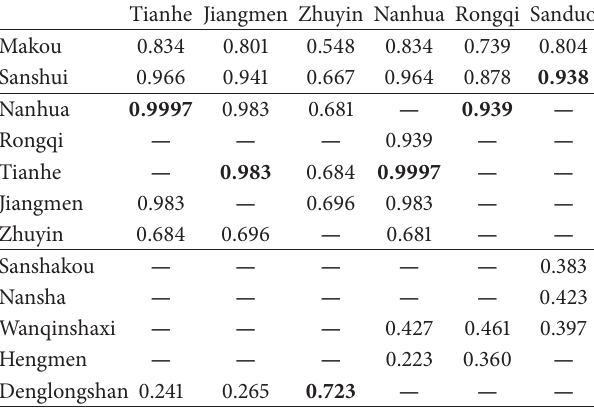
Table 10: Correlation coefficient (CC) among physically relevant